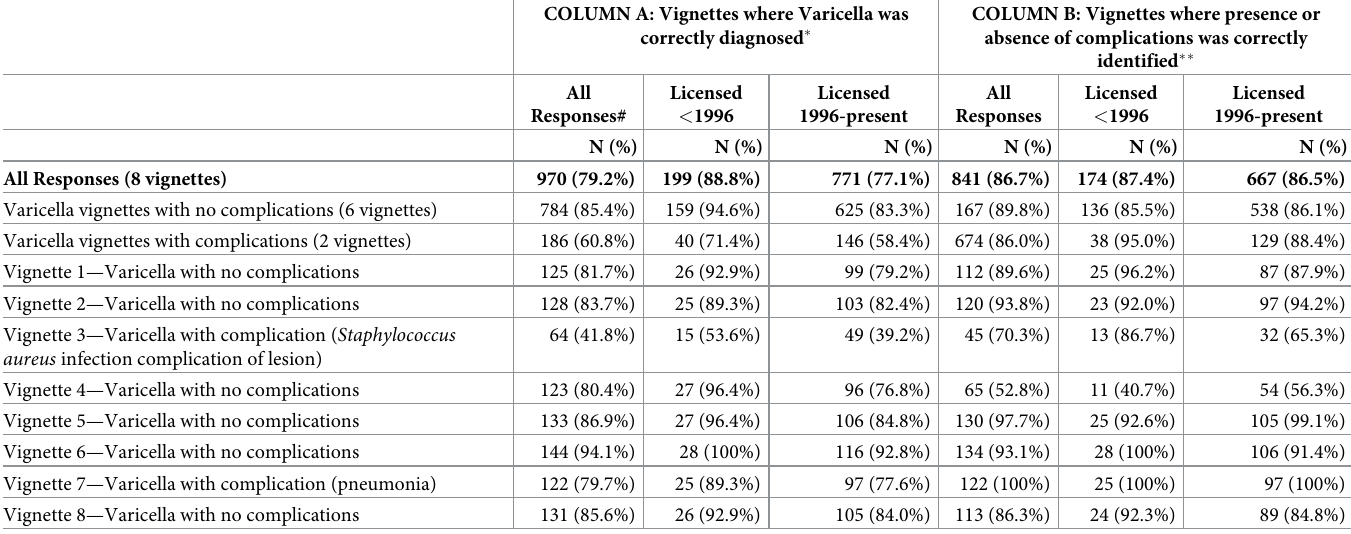
Table 4. Varicella diagnosis and categorization.